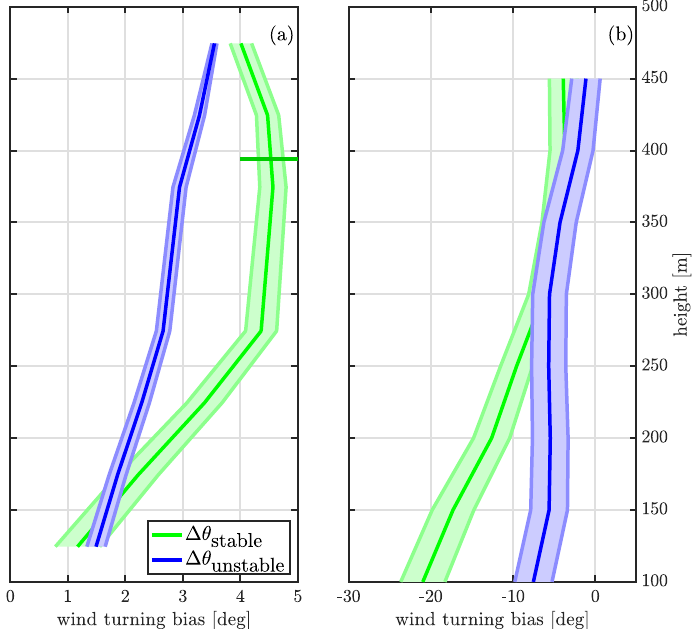
Figure 5. Mean profiles of wind turning bias at FINO3 ( a ) and Hamburg ( b ), given by the difference between the lidar and NEWA-WRF wind directions ( ∆ θ ), under unstable (blue) and stable (green) conditions. The mean PBL height under stable conditions, based on NEWA-WRF, is plotted as a horizontal green